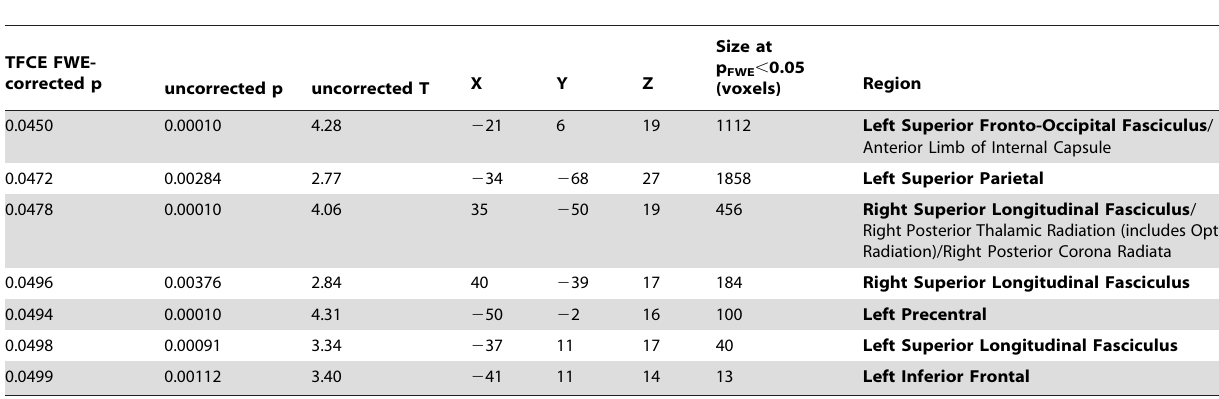
All correlations are negative, and only those clusters surviving TFCE FWE-correction at P , 0.05 are listed. Coordinates are in MNI-space (mm).